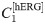
State transition diagram of the Markov model for the hERG channel.
C1[hERG]–C3[hERG] are closed states, O[hERG] is the open state and I[hERG] the inactivation state.